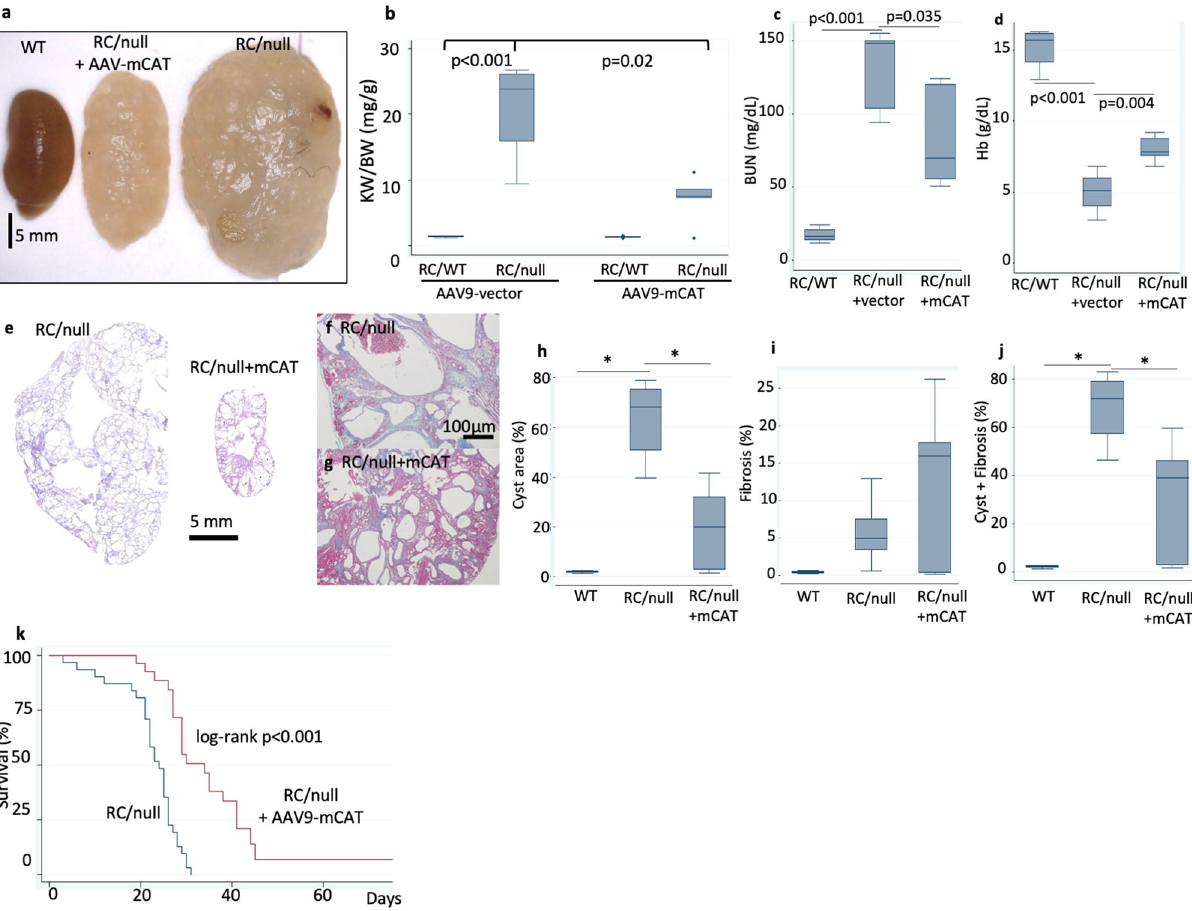
Fig. 4 Overexpression of mCAT delays renal failure and mortality in RC/null mice. a Huge RC/null gross pathology of kidneys from 24-days-old WT and RC/null mice, and RC/null mice treated with AAV9-mCAT (2 ×10 9 /g) (representative image shown; n = 4 − 6). b Kidney weight normalized to body weight in RC/WT or RC/null mice treated with AAV9 vector alone (AAV9-vector) or AAV9-mCAT. c BUN (mg/dL) and d hemoglobin (g/dL) in RC/WT mice or RC/null mice treated with AAV9 vector alone (AAV9-vector) or AAV9-mCAT; n = 3 − 7. e Representative PAS staining of kidney sections from RC/null mice, untreated and treated with AAV9-mCAT. f − g Trichrome staining of kidney section from RC/null mice untreated and treated with AAV9-mCAT. h − j Quantitative analysis of cysts area ( g ), fi brotic area ( h ), and combined cysts and fi brotic area ( i ). * p < 0.05.; n = 4 for WT; n = 15 − 18 for each of the other groups. k Survival curves of RC/null mice untreated or treated with AAV9-mCAT (2*10 9 /g); n = 31 for RC/null, n = 19 for RC/null +